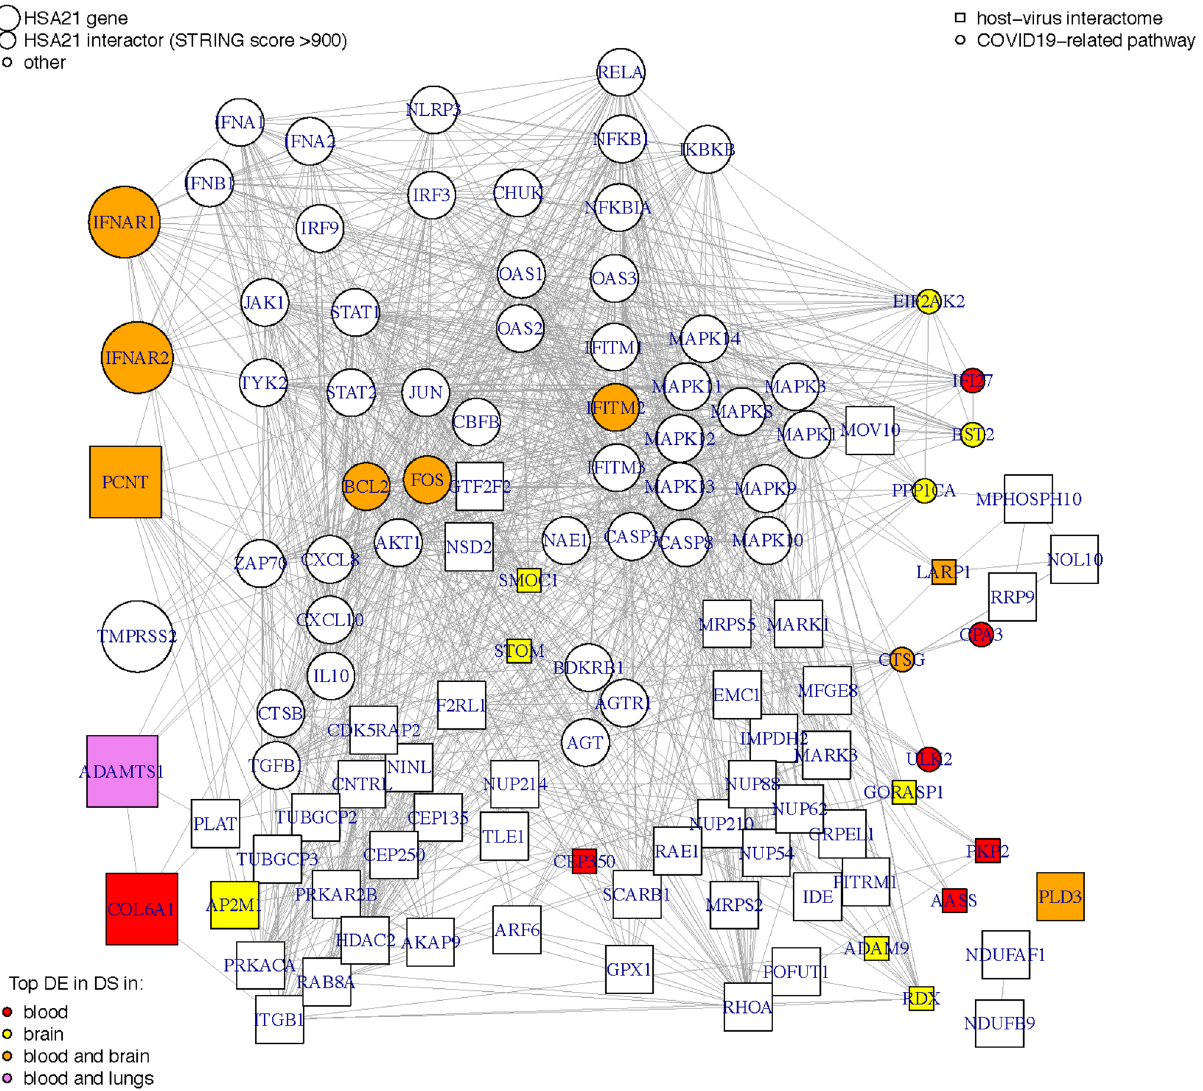
Figure 1. DS-SARS-CoV-2 network. Molecular interaction network where the size of each node represents a HSA21 gene (bigger size), a HSA21 interactor (medium size, STRING score ≥ 900) or a non-HSA21 gene (smaller size) found consistently deregulated in DS. Circles represent the genes related to infection with SARS- CoV-2 as reported in WikiPathways , and squares are host proteins found in the SARS-CoV-2-Human Protein– Protein Interactome. Genes found consistently DE in at least 4 DS transcriptomic studies are colored depending on the tissue: in red when mainly DE in blood, yellow when mainly deregulated in brain, and orange when found in both blood and brain tissue. The gene ADAMTS1 is deregulated in blood but is also a pro-angiogenic factor upregulated in DS lungs (in purple) 29 . The edges indicate a protein–protein interaction score (STRING score ≥